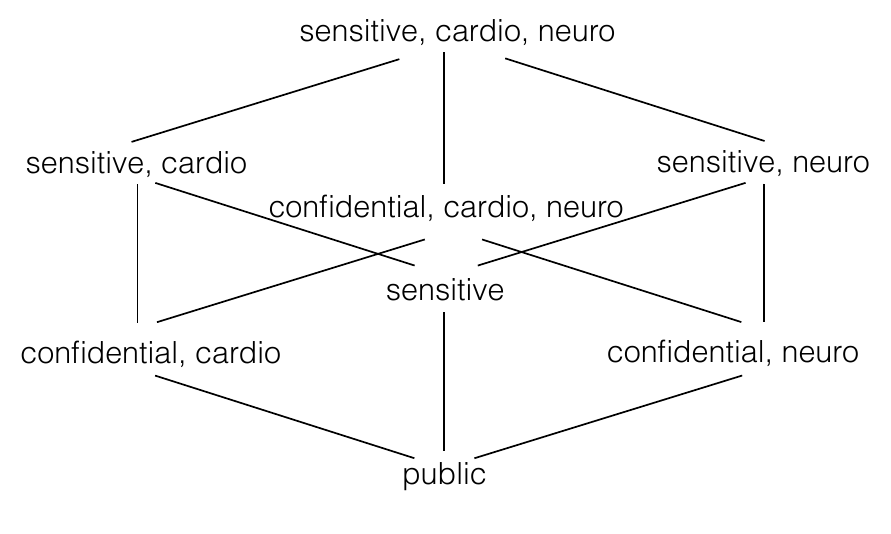
Figure 2. Hasse diagram for an example lattice-based access control (LBAC) policy using three security levels and two